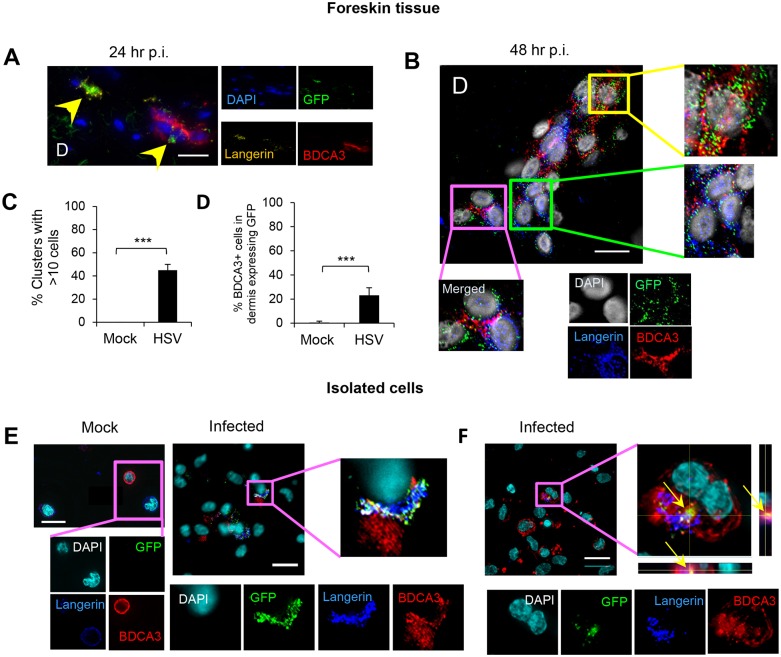
Migration of HSV infected LCs into the dermis and their subsequent interaction with BDCA3+ dermal DCs in clusters.(A) (B) (C) (D) LCs and BDCA3+ dDCs in the dermis of foreskin explants at 24 hr p.i. (A) & 48 hr p.i. (B, C, & D), yellow arrows: GFP+langerin+ cells, green box: GFP+langerin+ cells, yellow box: GFP+BDCA3+ cells, pink box: GFP/langerin+BDCA3+ dermal DCs. (C) Proportion of GFP+LC/BDCA3+ DC clusters with >10 cells, n = 3, mean ± SEM, p***<0.001. (D) Proportion of BDCA3+ dermal DCs expressing GFP, n = 3, mean ± SEM, p***<0.001. BDCA3+ cells with or without GFP expression were quantified in 20 representative fields per sample at 60x magnification. (E) (F) Isolated skin LCs and BDCA3+ dermal DCs: LCs were pulsed with v-UL37GFP for 2 hr, incubated for 12 hr then washed before co-culturing with BDCA3+ dermal DCs for another 6 hr. Images were acquired by maximal intensity Z projection (A, B, E & F) and orthogonal views with the xz and yz planes (F). Scale bar indicates 20 μm. Images are representative from 3 donors.